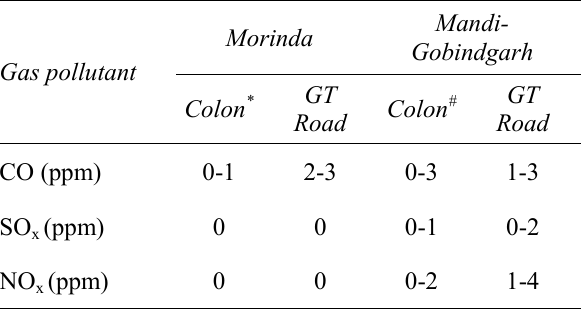
Table 4 : Levels of gaseous pollutants in the two sites.